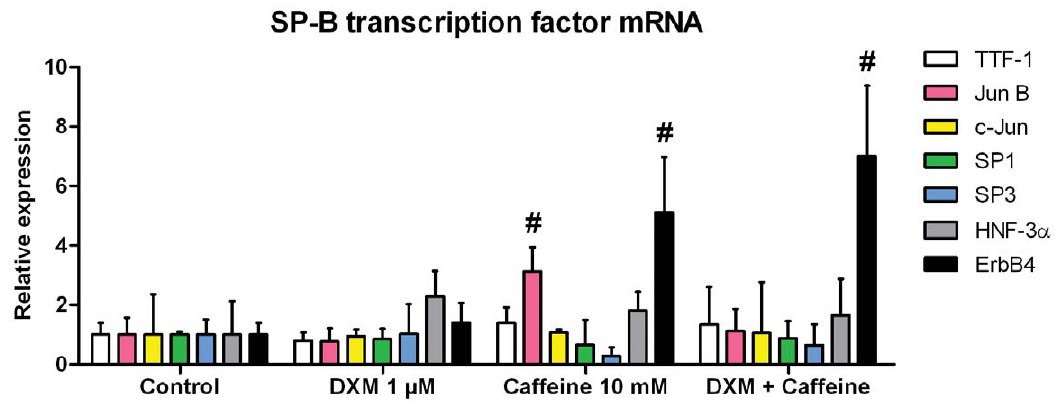
Figure 4. Influence of caffeine and dexamethasone on mRNA expression of SP-B transcription factors. H441 cells were treated with dexamethasone (DXM), caffeine, or combinations and 24 h later qPCR of TTF-1, Jun B, c-Jun, SP1, SP3, HNF-3 a , and ErbB4 mRNA was performed. Transcription factor mRNA levels were normalized to GAPDH, and fold differences compared to untreated cells were calculated. Means 6 SD of at least n=3 independent experiments are shown. # p , 0.05 compared to cells treated with dexamethasone.